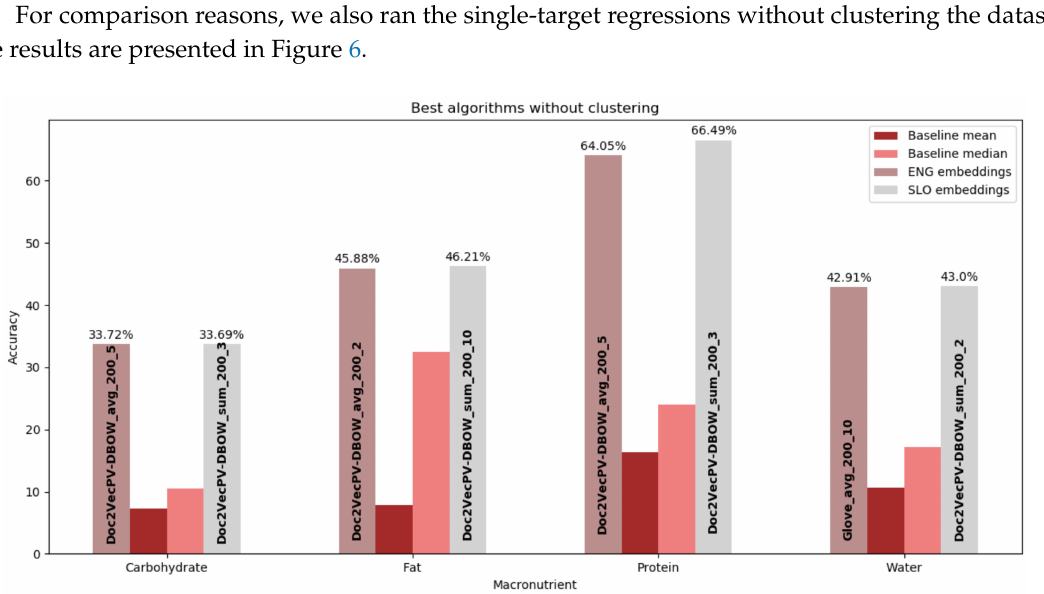
Figure 6. Best prediction accuracies for each macronutrient obtained from the embeddings for the English and Slovene names compared to the baseline mean and median from the whole